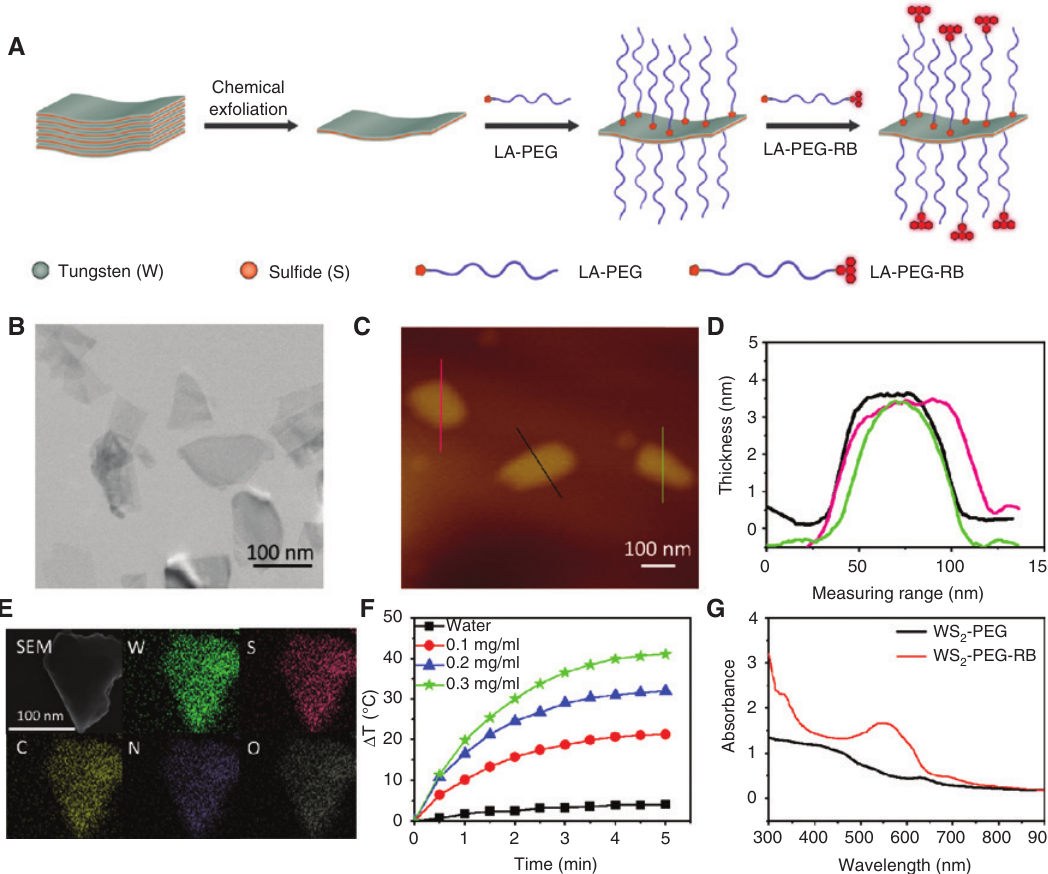
-based NSs. 2 -based NSs. (B) TEM images of WS 2 -PEG NSs. (F) Photothermal heating curves of the WS 2